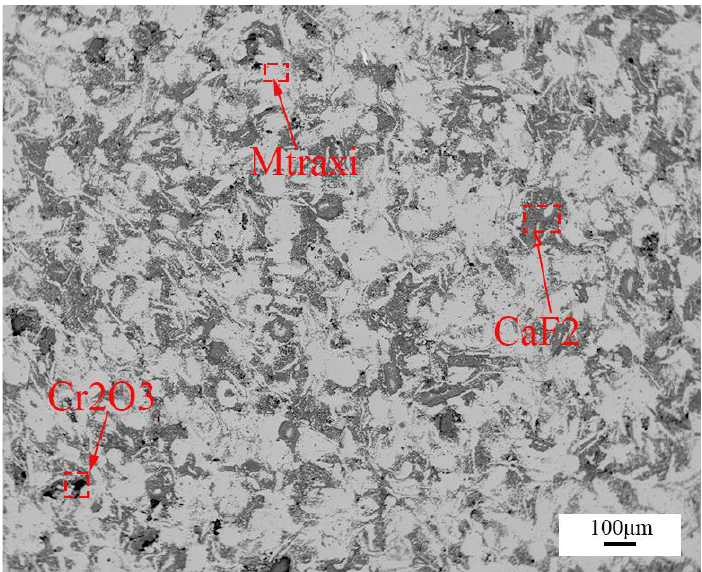
Figure 1. Microstructure of sample